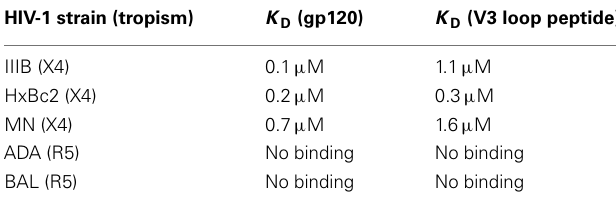
Table 4 |Affinities of CX4-M1 to gp120 andV3 loop peptides, respectively, from X4 tropic and R5-tropic HIV-1.